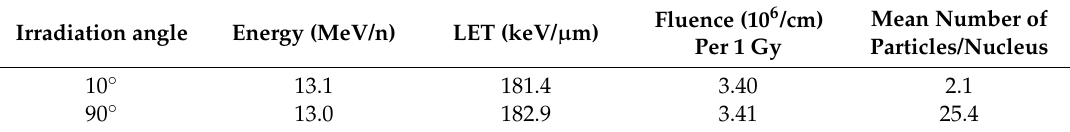
Table 1. Irradiation Parameters for Different Irradiation